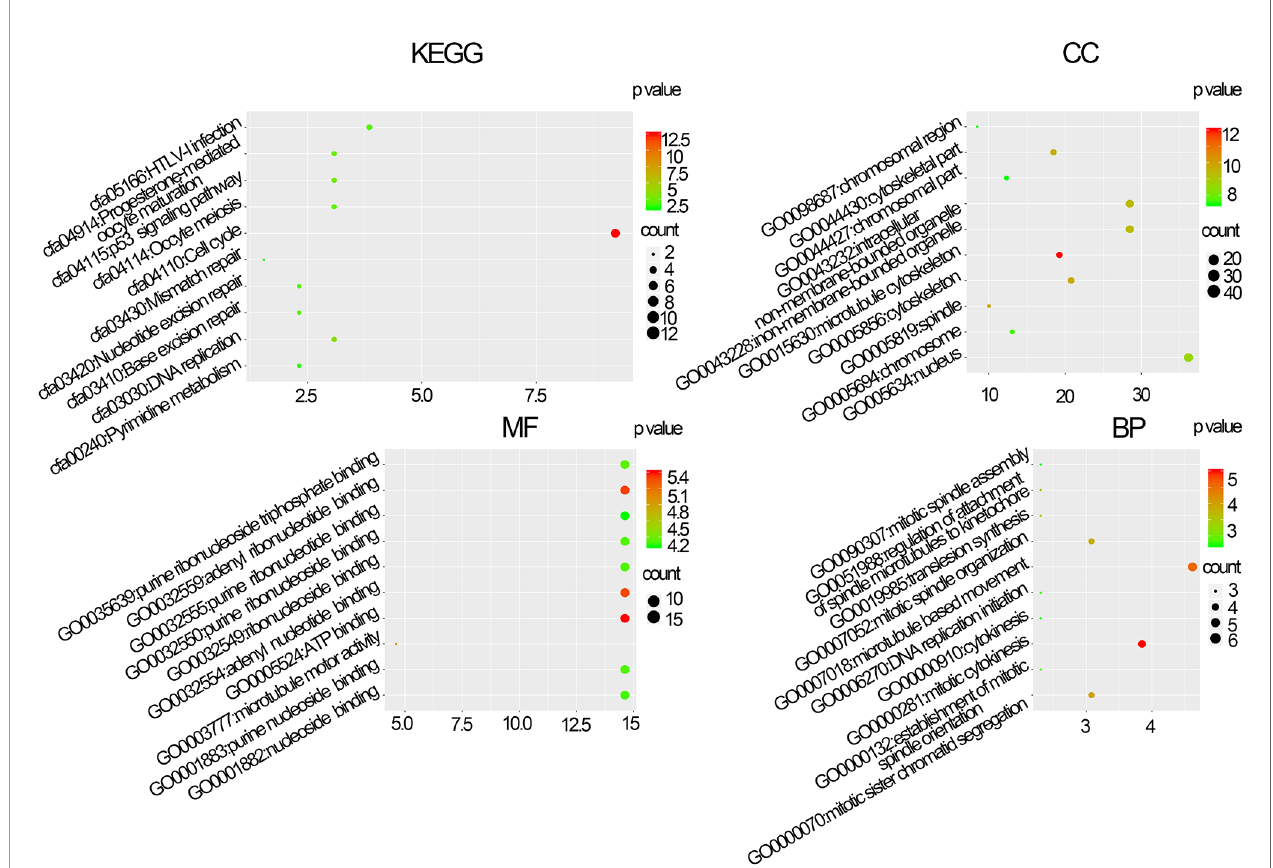
FIGURE 3 | Molecular function (MF), biological processes (BP), cellular composition (CC), and Kyoto Gene and Genomic Gene Encyclopedia (KEGG) pathway enrichment analyses of co-expression modules. The x-axis shows the ratio of genes and the y-axis shows the KEGG pathway terms. The -log10 (p-value) of each term is colored in accordance with the